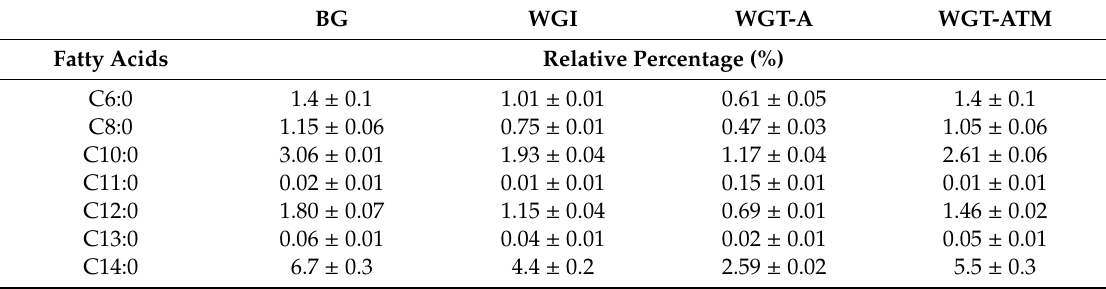
Table 2. Chemical composition with regard to lipophilic compounds of A. sativum samples (mean ± SD).